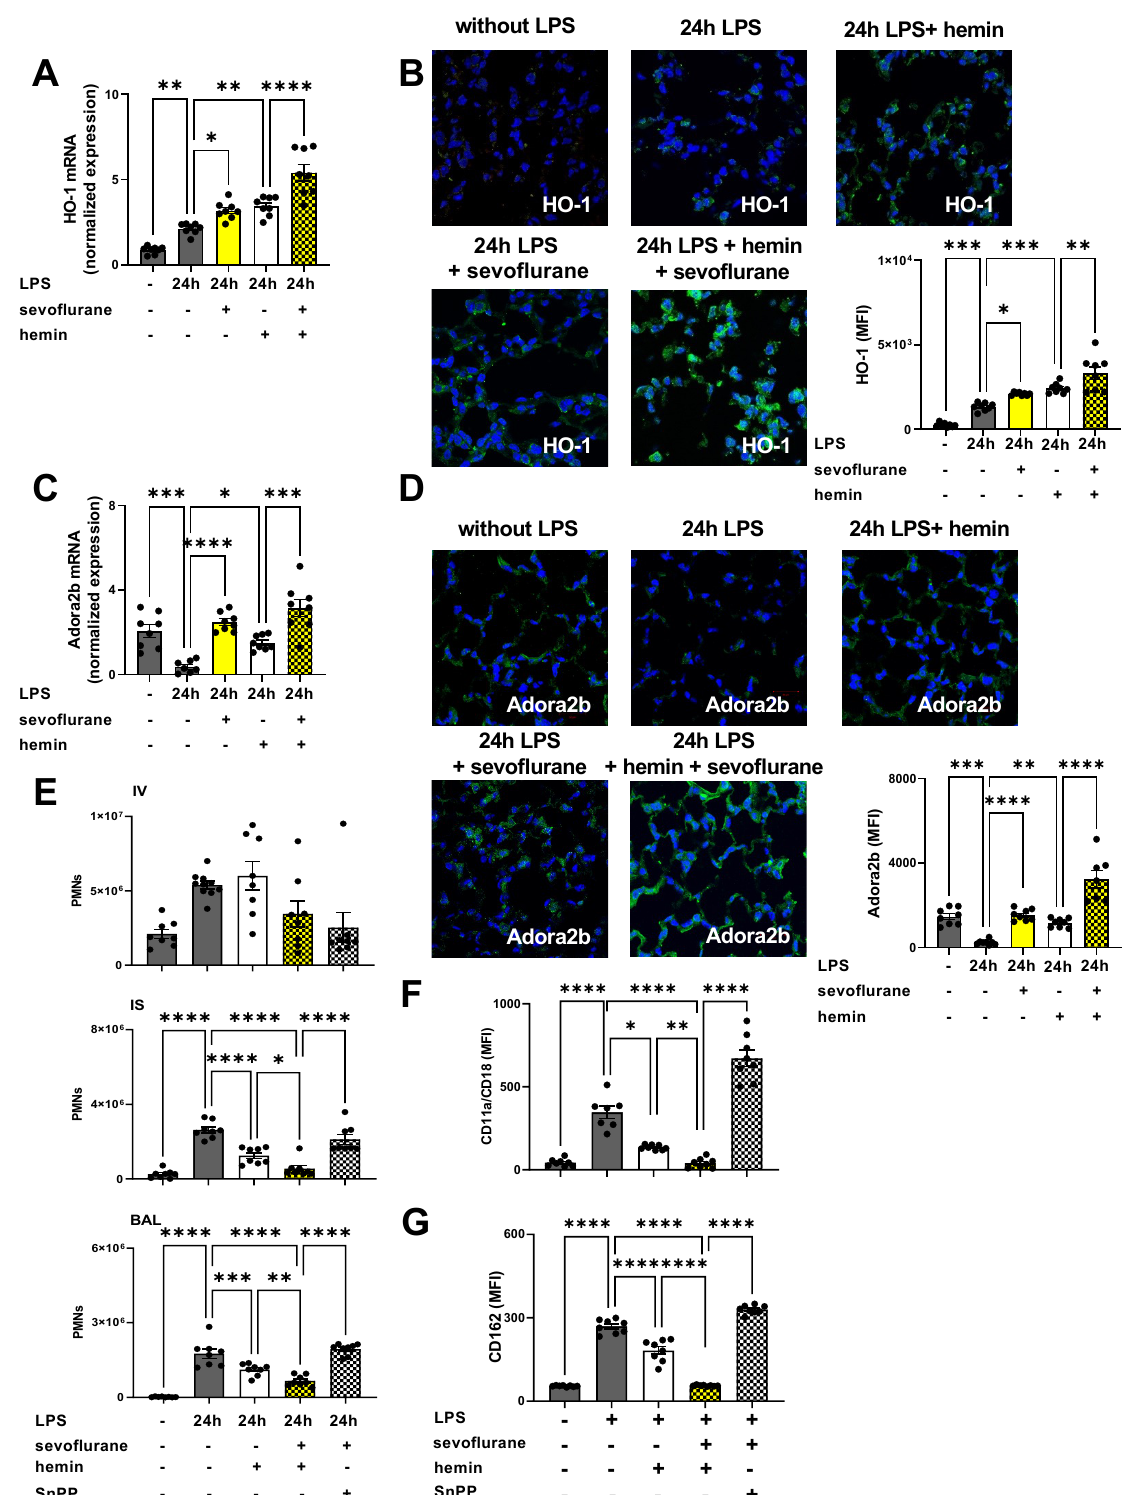
Figure 8. The impact of sevoflurane on heme oxygenase-1 (HO-1) modulation during acute pul- monary inflammation. ( A ) Gene, and ( B ) protein expression of HO-1 was evaluated in the